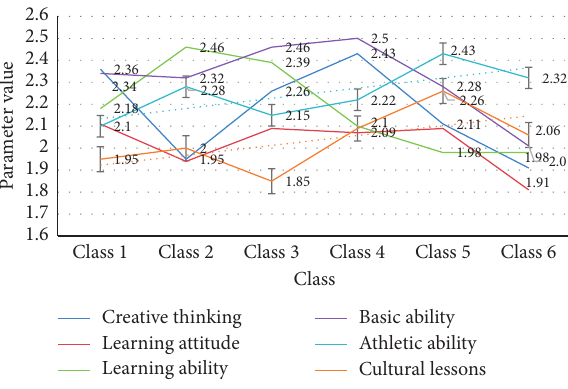
Figure 4: Female students’ mastery. Table 3: Male students after